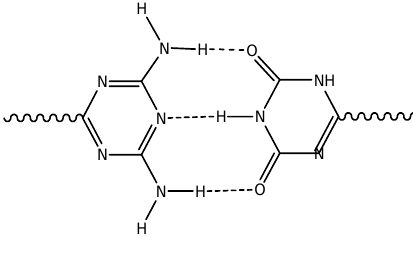
and OH substituted triazines. 2